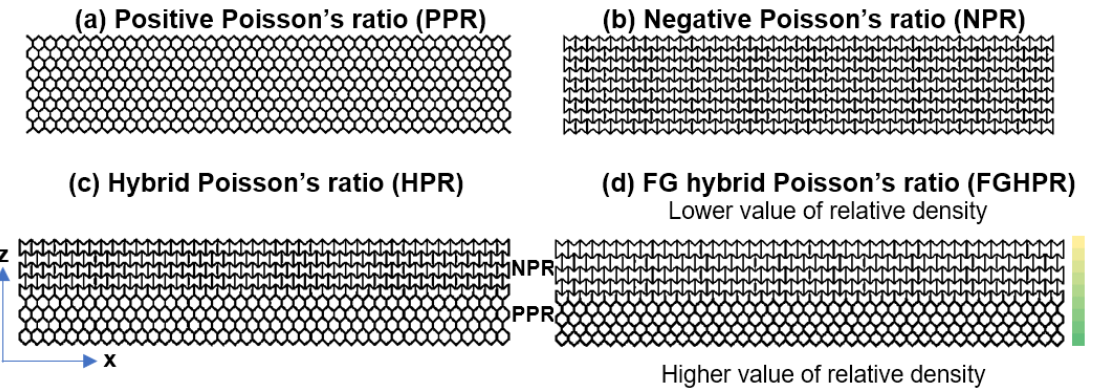
Figure 3. The front view of the base layer used for the creation of: ( a ) the PPR structure, ( b ) NPR structure, ( c ) HPR structure, and ( d ) FGHPR structure with a 1D graded density in the z direction.